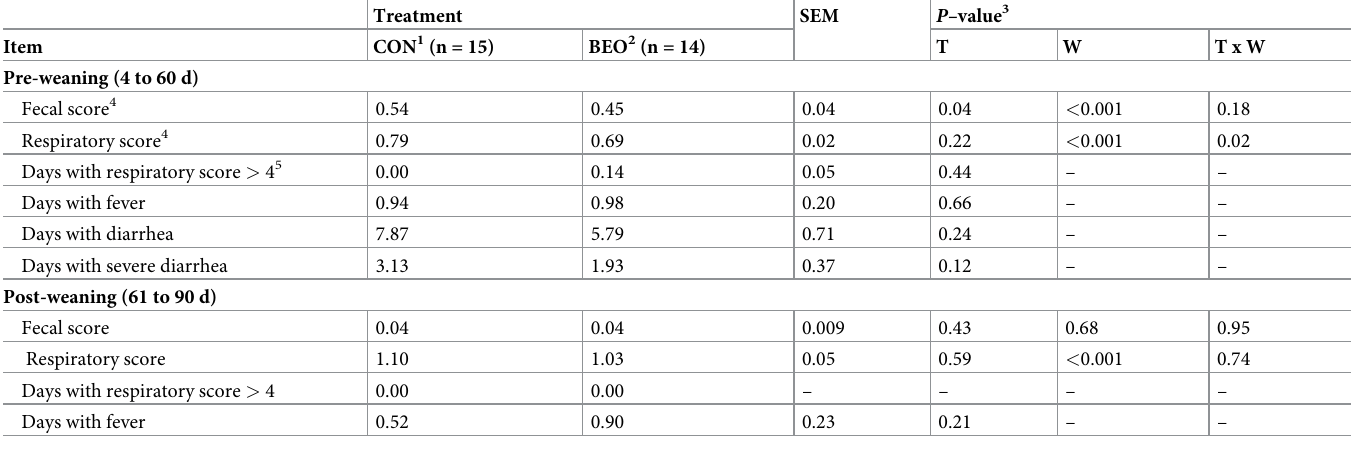
Table 7. Pre and post-weaning mean values of the fecal score, respiratory score, days with a respiratory score above 4, days with fever, days with diarrhea, days with severe diarrhea of control heifers (CON) and heifers supplemented with a blend of essential oils (BEO) in milk replacer during pre-weaning.